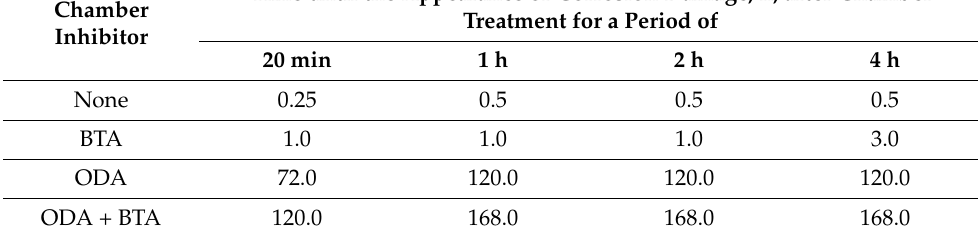
The mean value of E cor of a chamber-treated steel electrode in borate buffer was 0.095 V. Its anodic polarization did not result in noticeable changes in current up to E = 0.15 V.